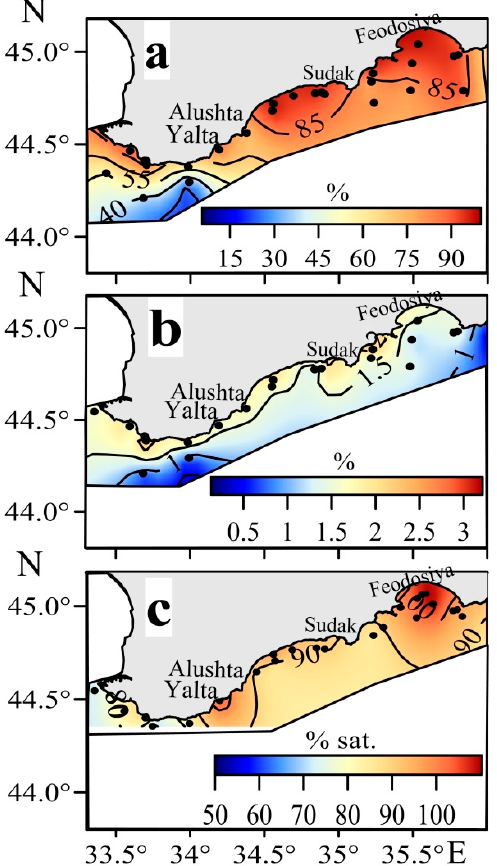
Figure 4. Spatial distribution of the clay fraction ( a ) and C org ( b ) in the sediment surface layer, and ( c ) oxygen saturation in the bottom waters of the SCC region. ( c ) oxygen saturation in the bottom waters of the SCC